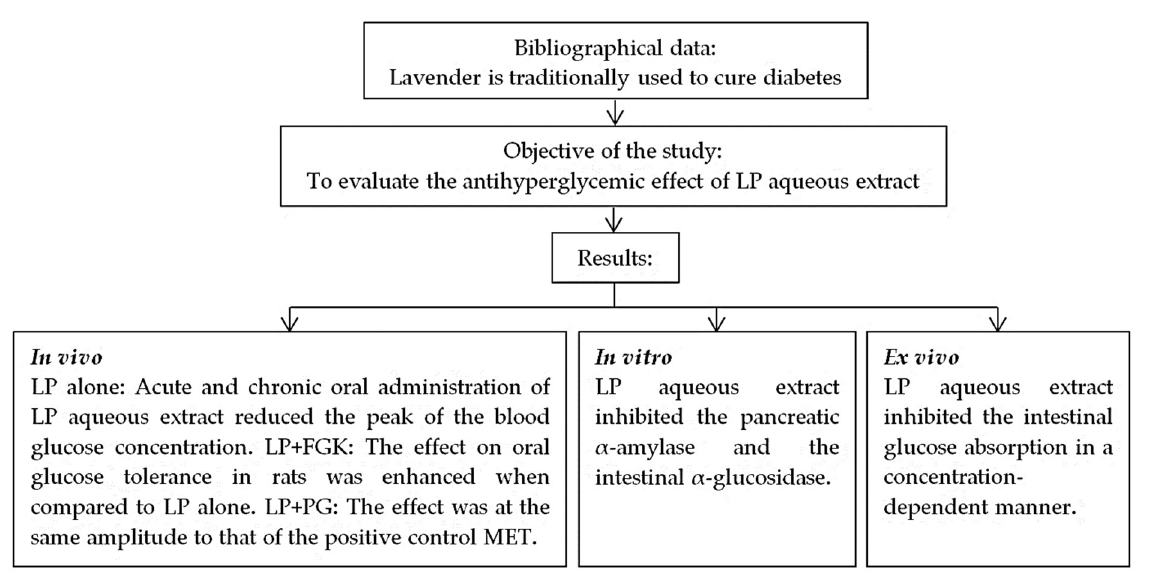
Figure 10. A schematic diagram of the study.